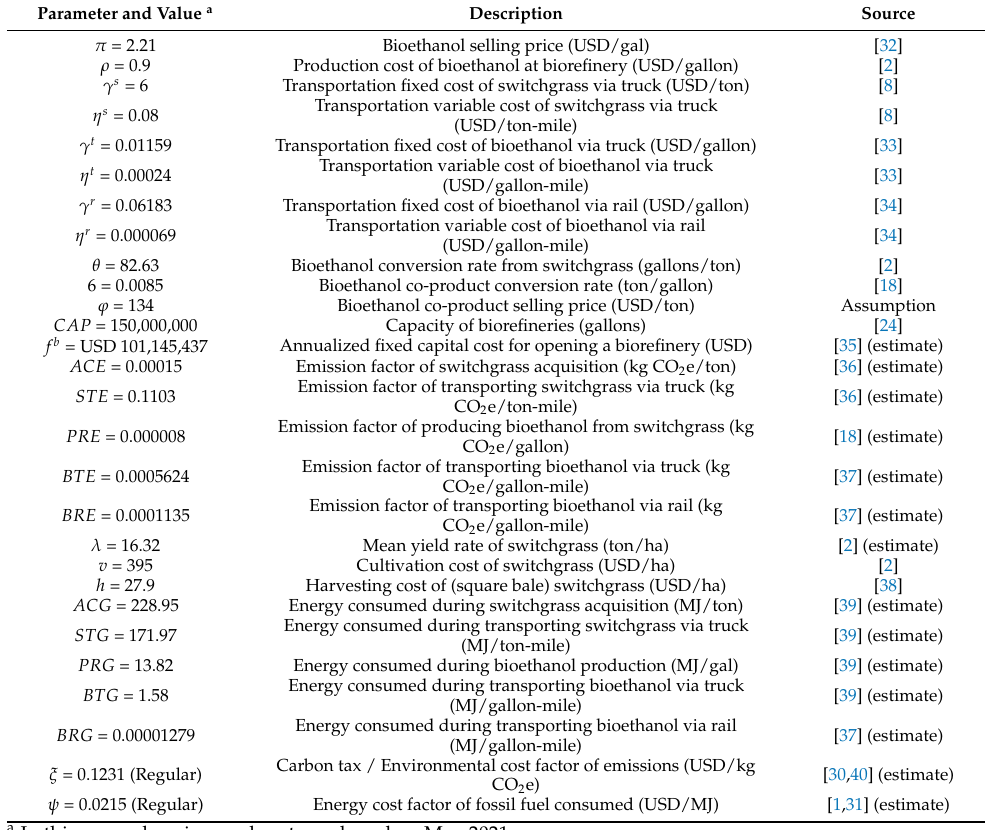
Table A1. Values of input